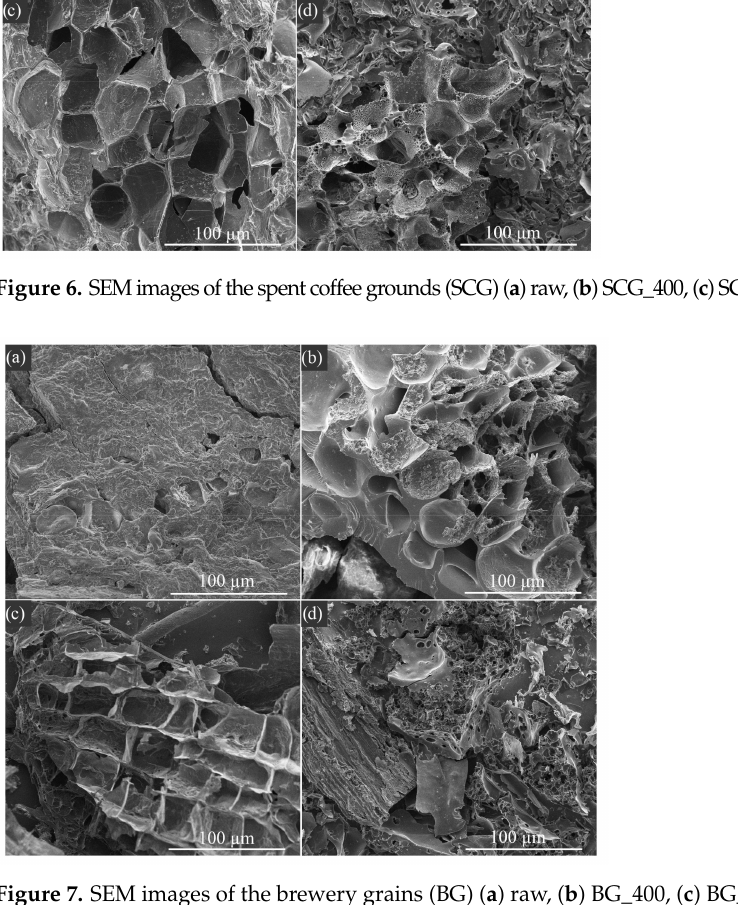
Figure 7. SEM images of the brewery grains (BG) ( a ) raw, ( b ) BG_400, ( c ) BG_500, ( d ) after activation.